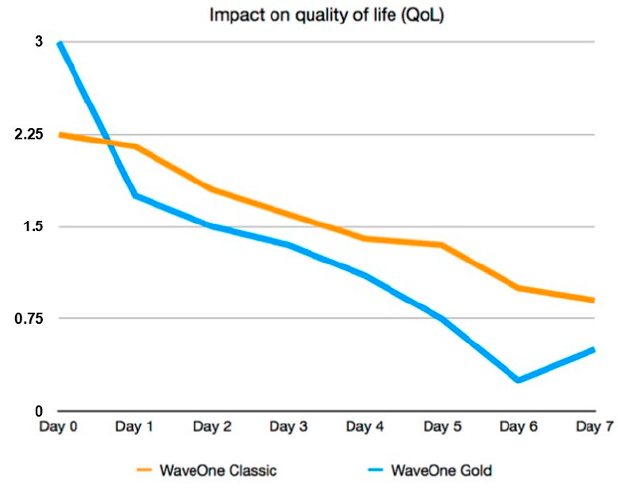
Figure 4. Quality of life value. Statistical significance on day six after treatment ( p = 0.021).